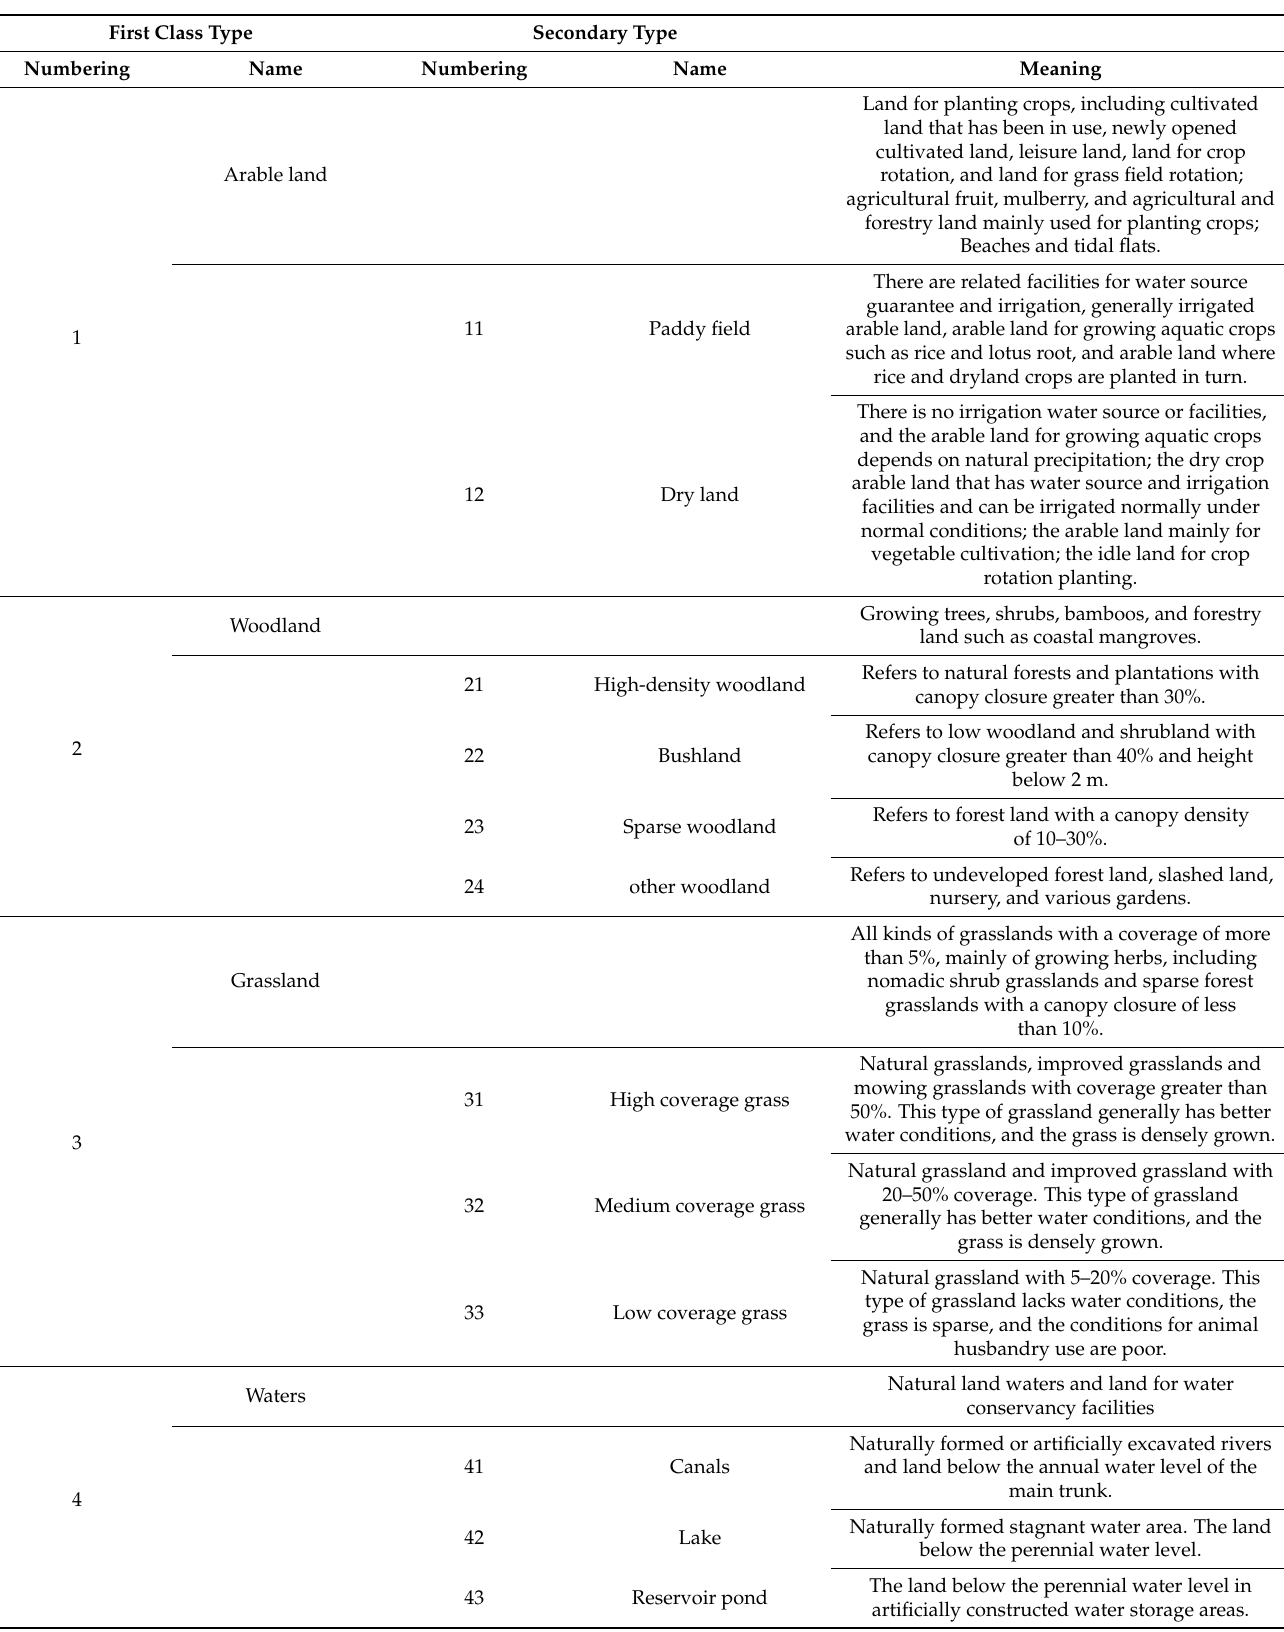
Table 1. Land-Use and Land-Cover Change classification